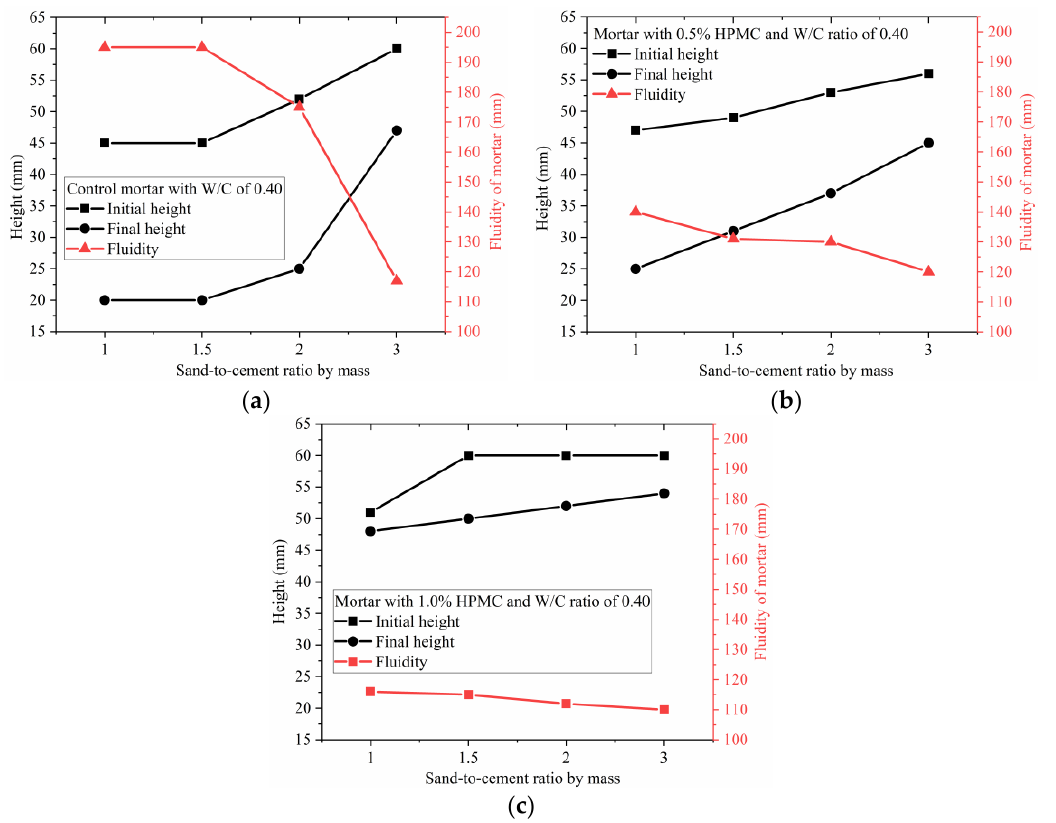
Figure 8. Initial height, final height and fluidity of SAC mortar Vs. S/C ratio with maintaining W/C of 0.40: ( a ) control mortar; ( b ) mortar with 0.5% HPMC; ( c ) mortar with 1.0% HPMC.